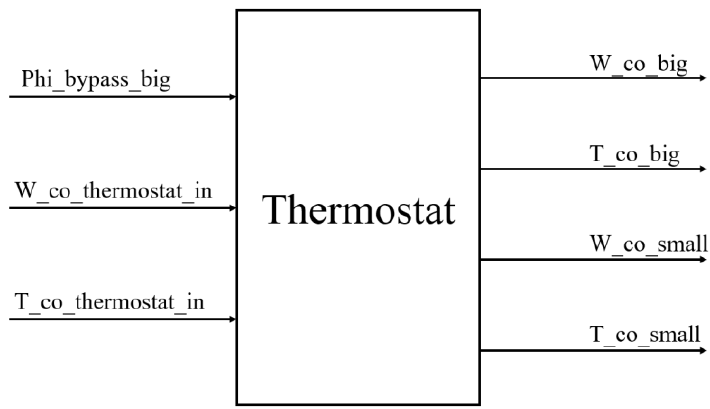
Figure 4. The input and output of the thermostat model.